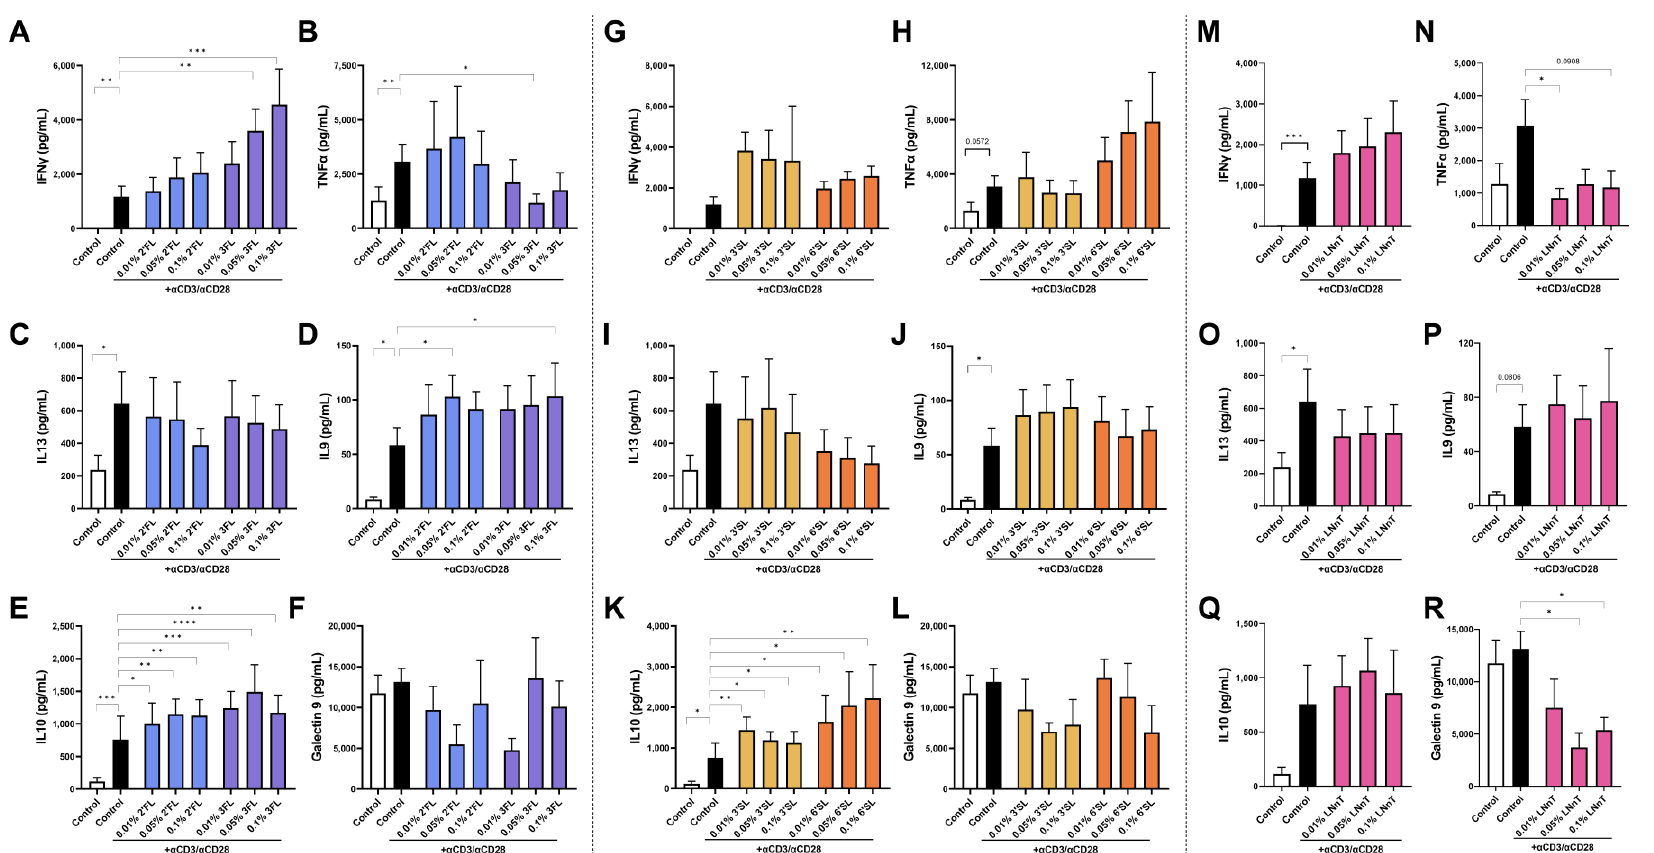
Figure 2. PBMCs were exposed directly low concentrations of all HMOS for 24 h while activated using αCD3 and αCD28. Concentrations of ( A , G , M ) IFNγ, ( B , H , N ) TNF α , ( C , I , O ) IL13, ( D , J , P ) IL9, ( E , K , Q ) IL10 and ( F , L , R ) galectin-9 were assessed in the supernatant. Data is analyzed by One-Way ANOVA followed by a Dunnett post-hoc test, n = 6 independent experiments using different donors, mean ± SEM (* p < 0.05, ** p < 0.01, *** p < 0.001, **** p < 0.0001.).